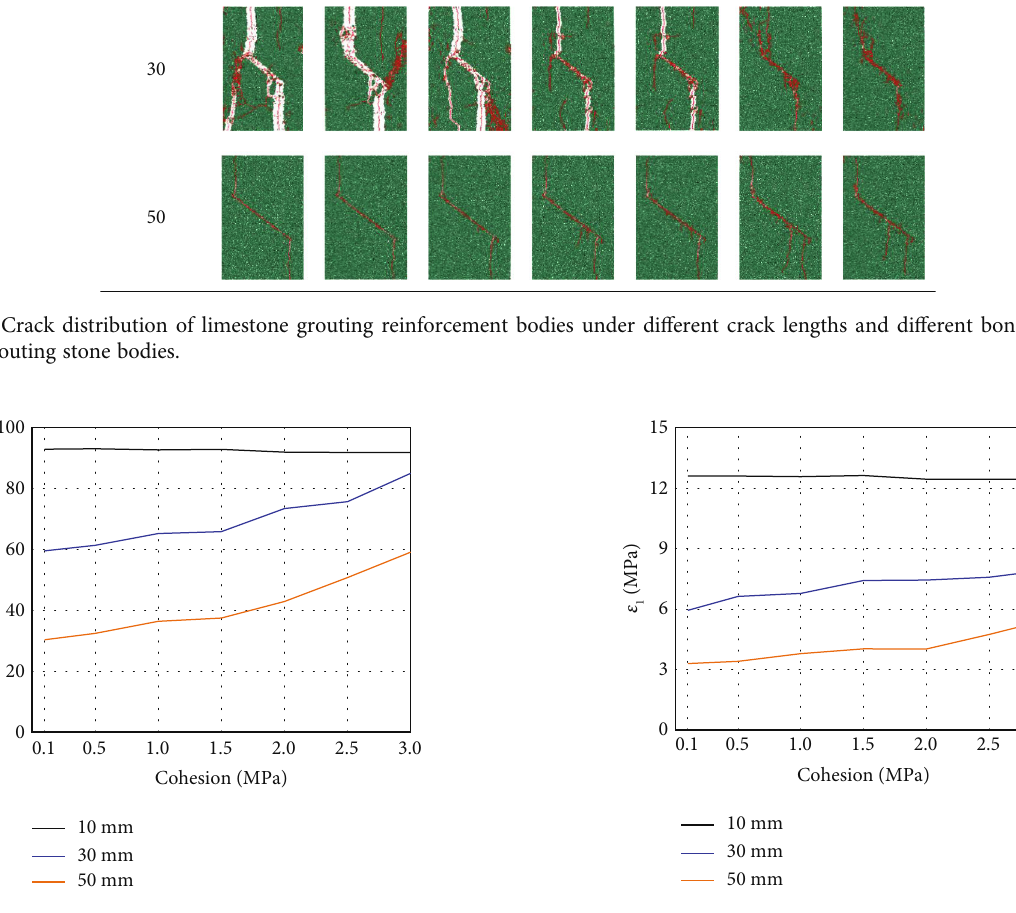
Figure 11: Uniaxial compressive strength of limestone grouting reinforcement bodies under di ff erent crack lengths and di ff erent bonding cohesion values of grouting stone bodies.